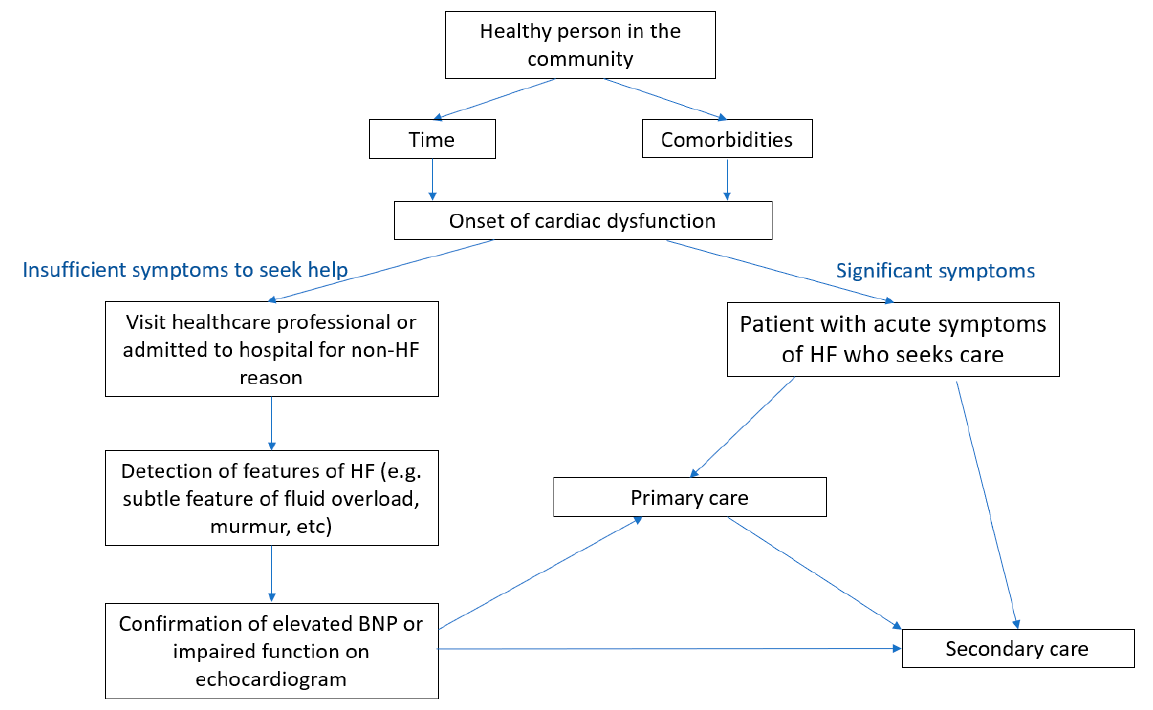
Figure 1. Pathways for population with heart failure and those at risk of heart failure.